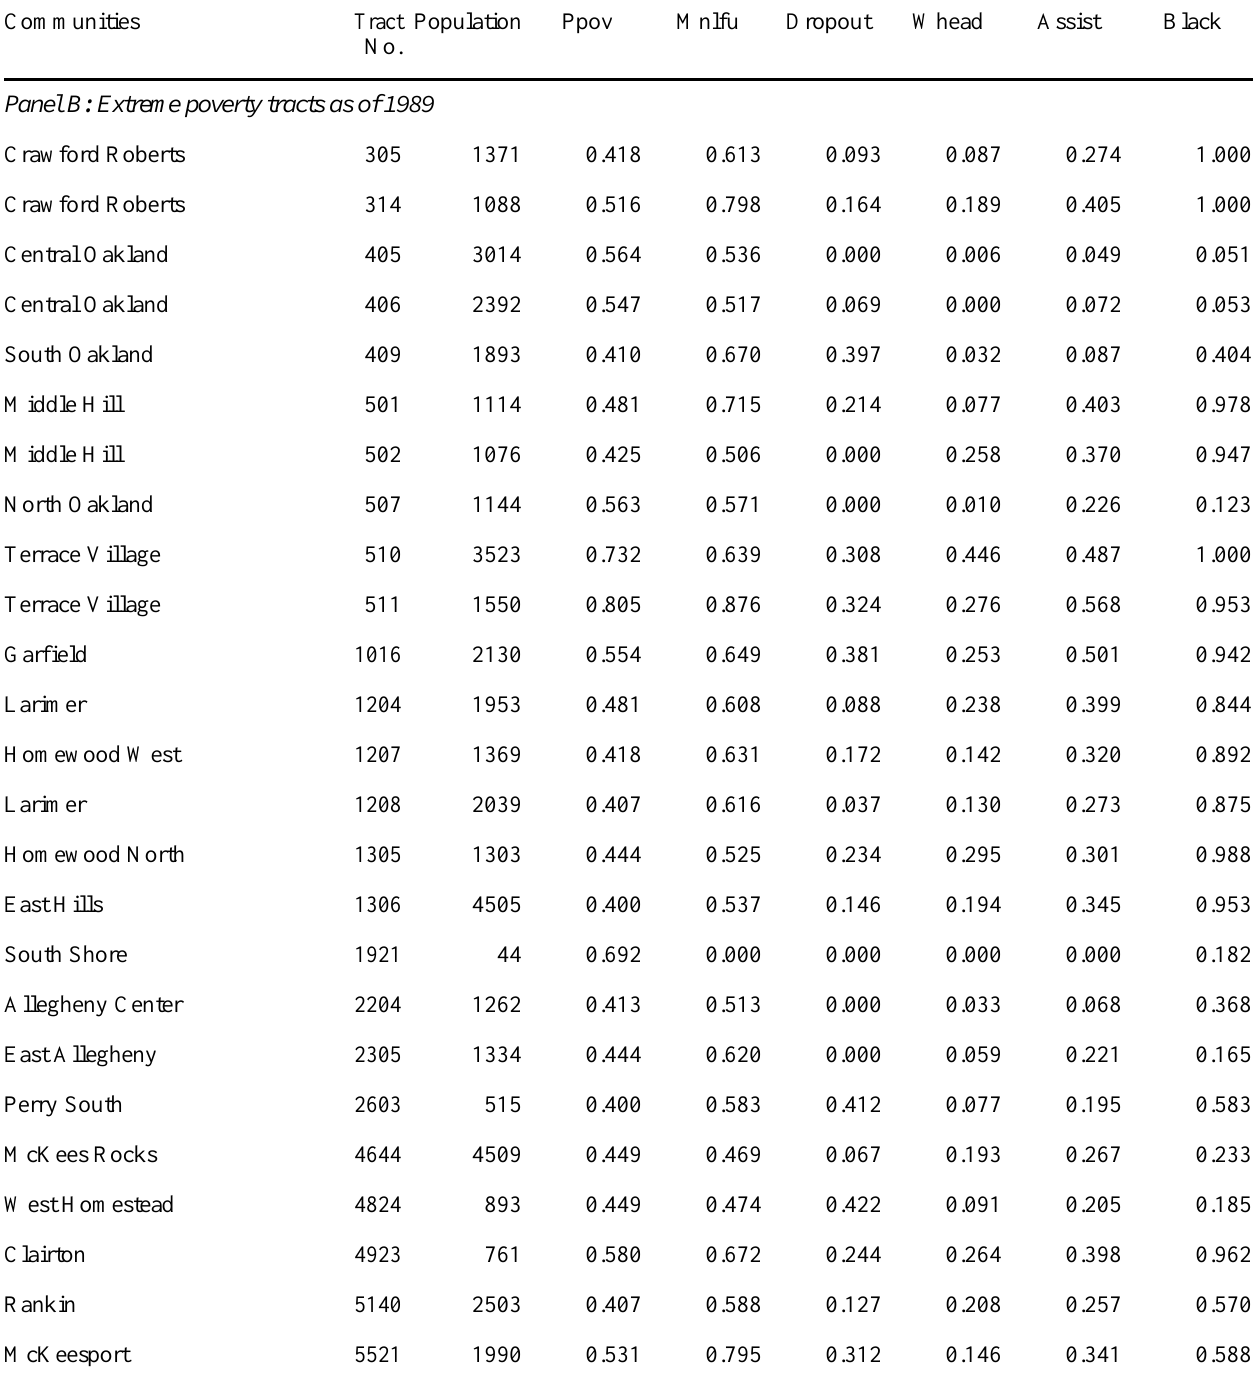
Table 11. Extreme poverty tracts in 1989, Pittsburgh Standard Metropolitan Statistical Area (cont.) Communities Tract Population Ppov Mnlfu Dropout Whead Assist Black No. Panel B: Extreme poverty tracts as of 1989